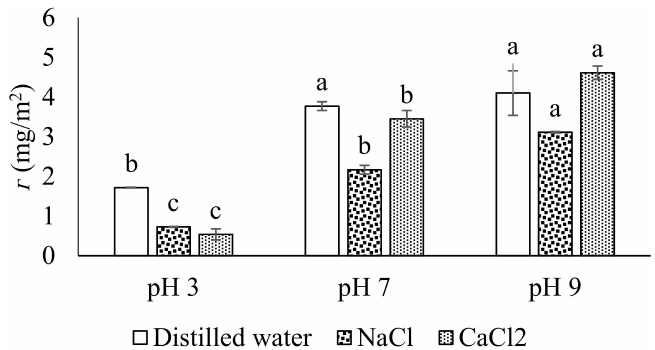
Figure 4. Interfacial protein concentrations of API at different pH mediums in distilled water and in the presence of NaCl and CaCl 2 . Different letters (a–c) represent significant differences among